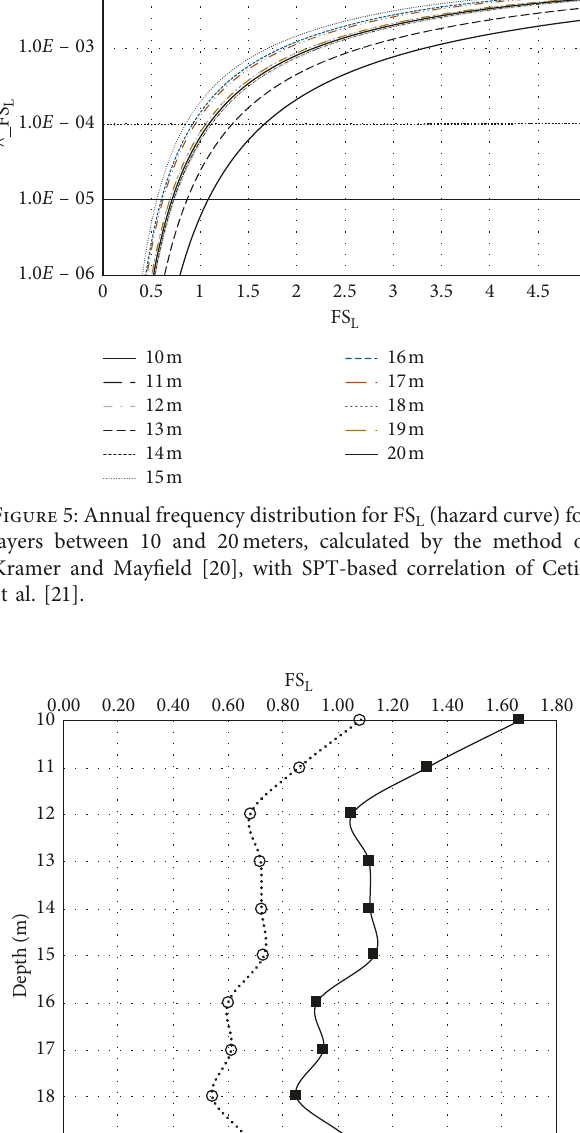
Figure 4: Distribution of the maximum magnitude in the PSHA model (truncated normal distribution with parameters: μ � 6.2; σ � 0,4; M w low � 5.8; M w high � 6.4) and distribution of contri- bution of magnitudes to the 6.37 E − 06/a level of hazard.